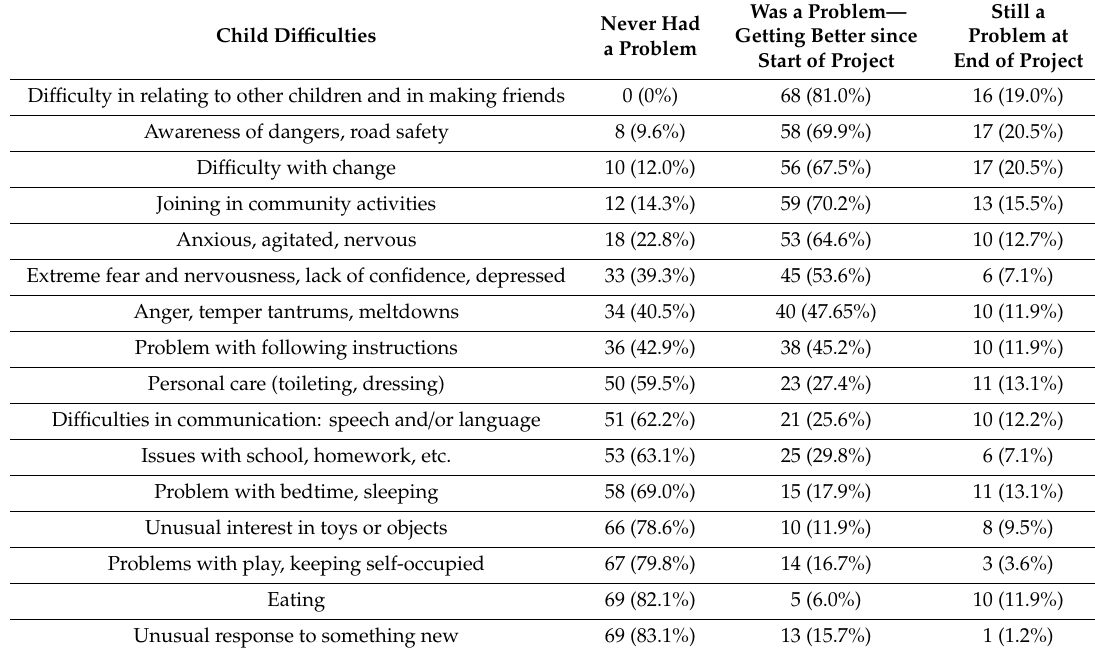
Table 1. The number and percentage of children rated by sta ff on outcomes achieved. Child Di ffi